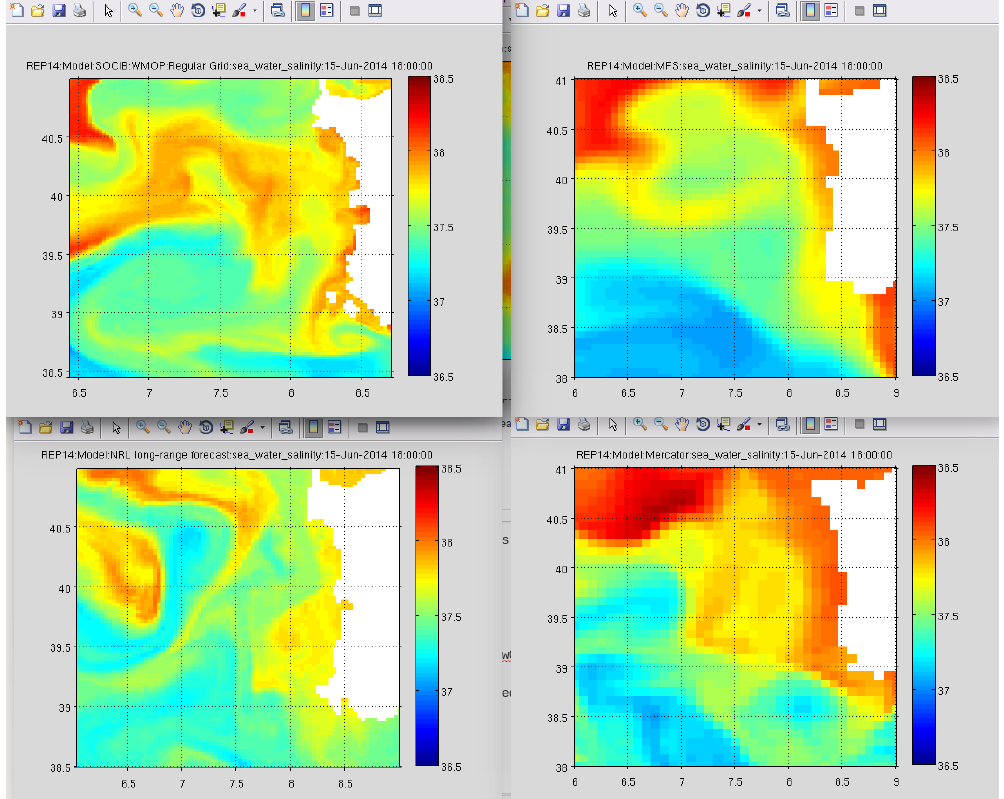
Figure 3. Comparison of surface salinity snapshots from four different models during REP14-MED field trial. By delivering data via web services with CF conventions and using NCTOOLBOX which understands CF conventions, these figures were able to be made without any model-specific code. © North Atlantic Treaty Organization, all rights reserved. Provided by